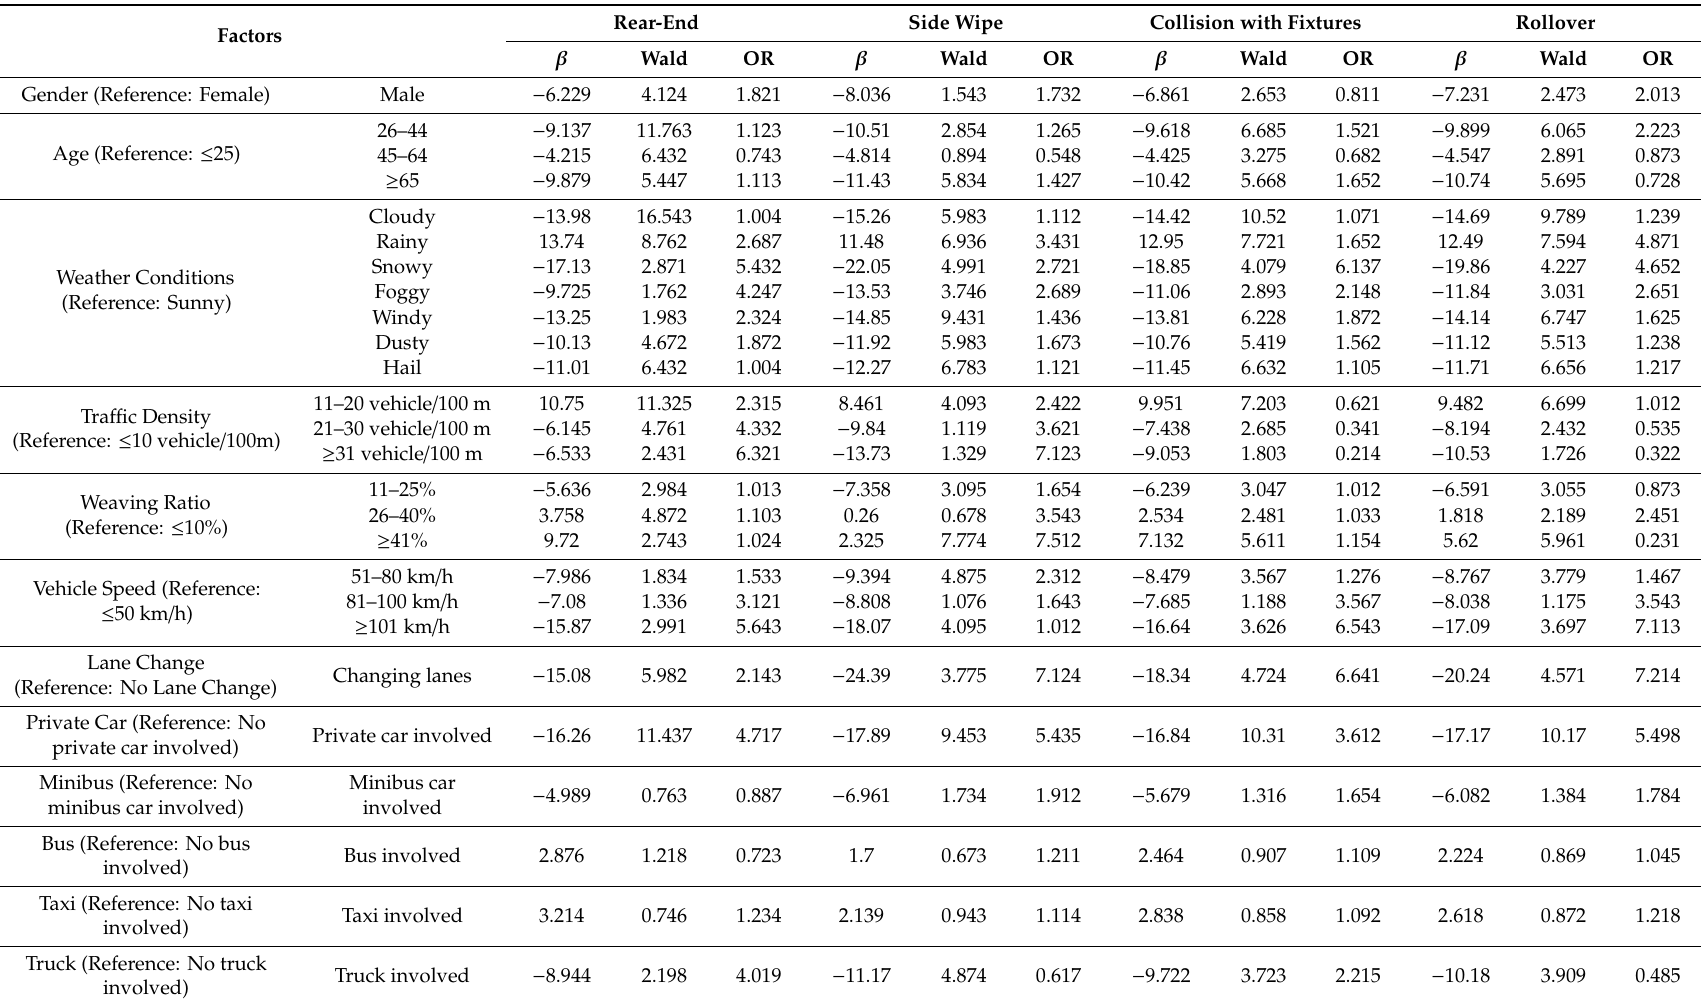
Table 1. Multinomial logistic regression